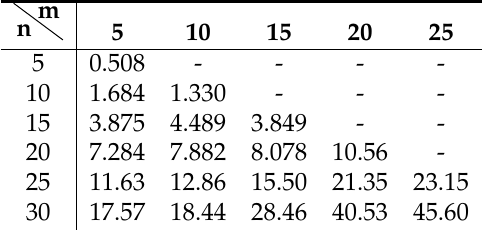
Table A8. Total solution time using Legendre polynomials in seconds for Problem